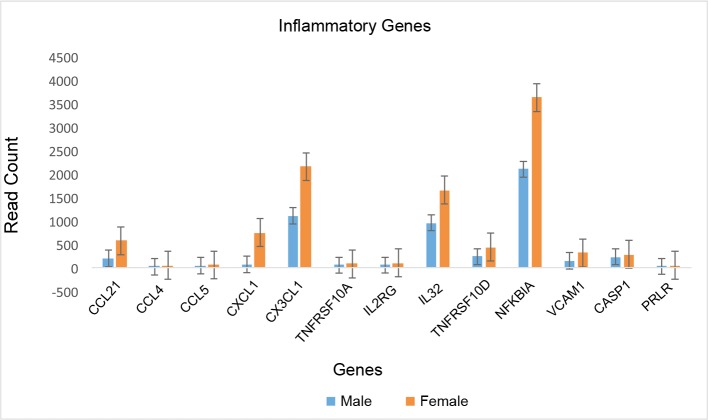
Female heart over expressed genes involve in inflammatory pathways.The bar graphs show the read count and error bars represent standard deviation.